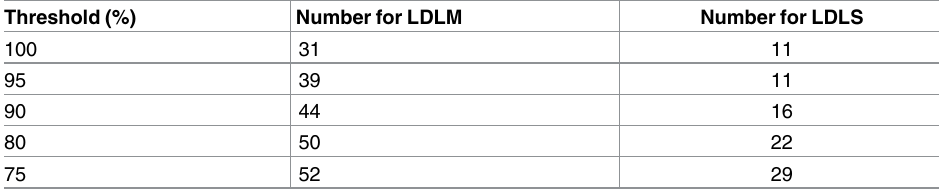
Table 7. Number of recoded stable covariables for the strategies LDLM and LDLS.